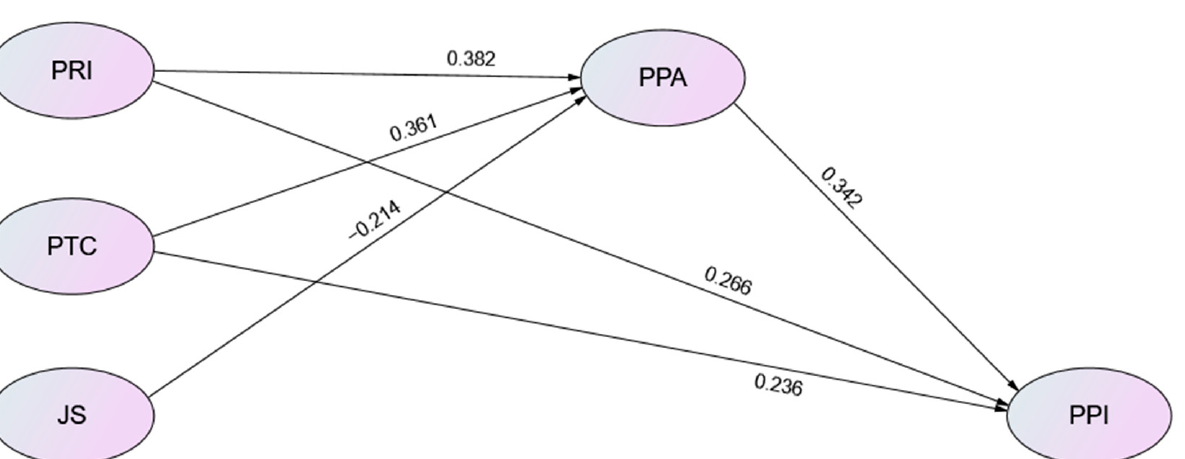
Table 6. The analysis of indirect effects.